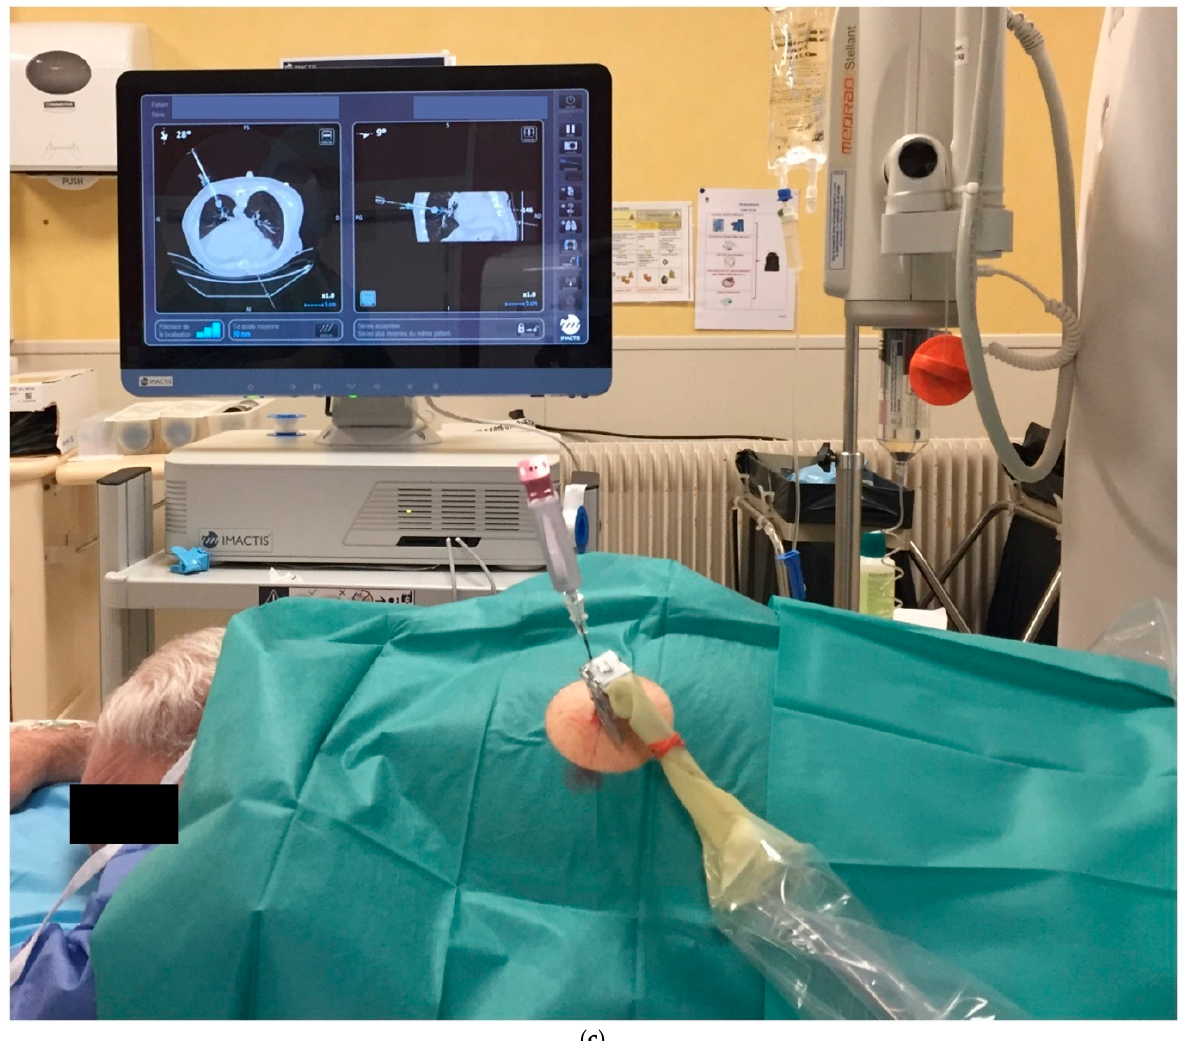
Figure 1. ( a ) Field generator placed on the patient’s skin; ( b ) magnetic receiver located inside the needle holder. ( c ) The station dynamically displays the position and orientation of the needle-holder on two-perpendicular 2D reconstructed CT-images.